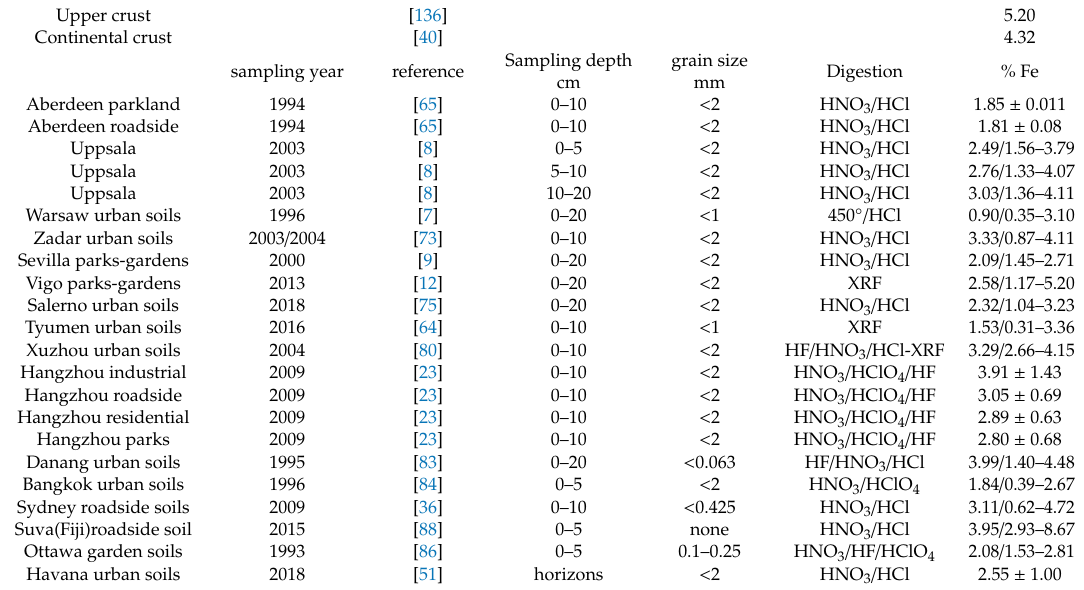
Table A2. Iron in urban soils.